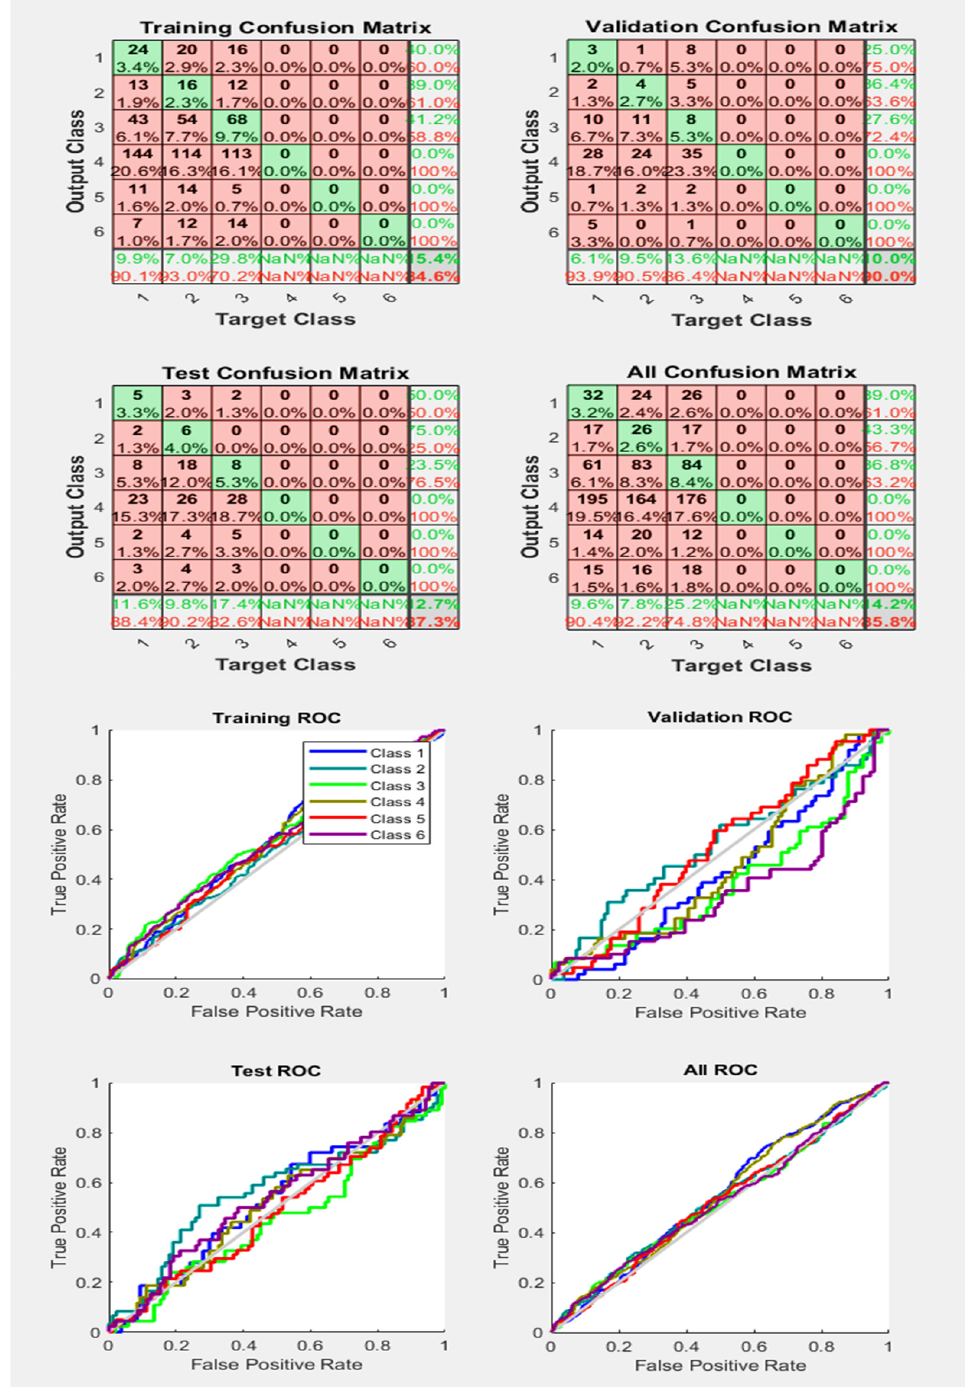
Figure 20. Neural Network Model ROC (Receiver Operating Characteristics) and Confusion Matrix for CGP TrainFcn/Activation Function at level 9 (RMS) Features for High Contact Resistance Fault with 85.8% Accuracy. Grey line shows diagonal of the ROC for indicating Class 1–6 lines are lying above or below or on it.